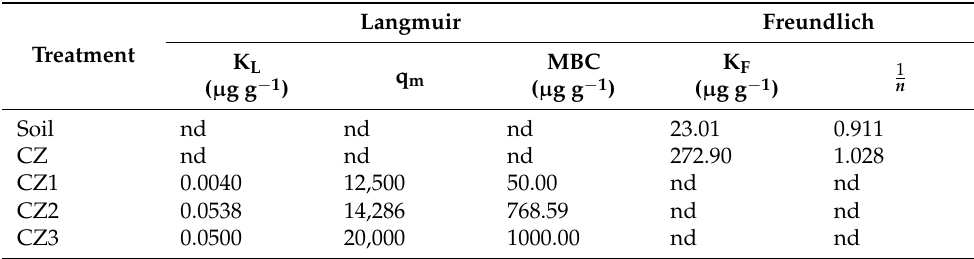
Table 20. Results from Langmuir and Freundlich isotherms for potassium adsorption by soil only and different amounts of clinoptilolite zeolite.